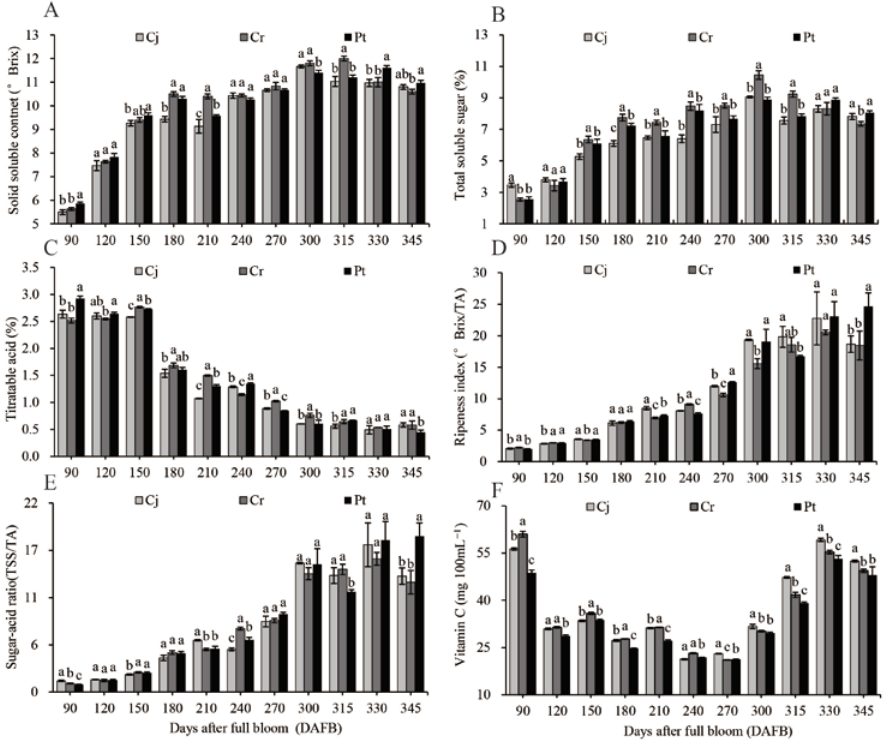
Figure 4. Dynamic changes in the soluble solid content: ( A ) total soluble sugar; ( B ) titratable acidity; ( C ) ripening index; ( D ) sugar–acid ratio; ( E ) vitamin C content; and ( F ) of blood orange grafted onto different rootstocks during fruit development and ripening.